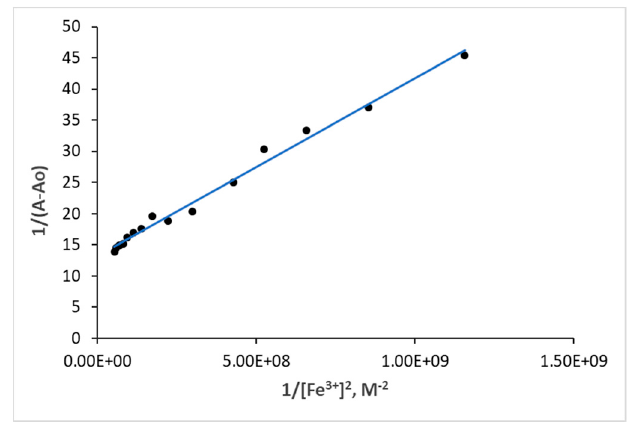
Figure 7. Benesi–Hildebrand plot for the 1:2 binding stoichiometry of azo 4c with Fe 3+ .